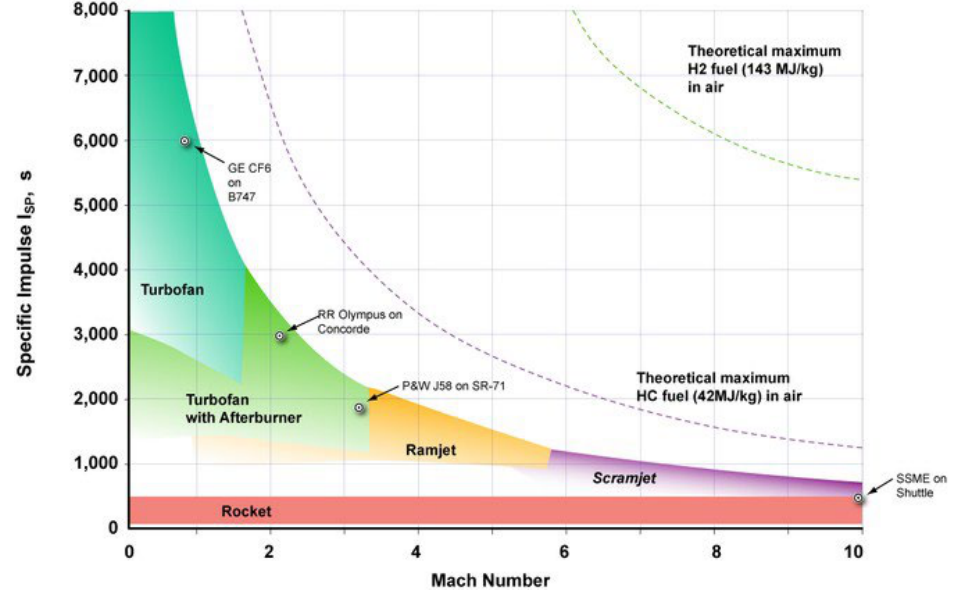
Figure 1. Specific impulse of different engines [1]. Traditionally, space planes and rockets equipped for hypersonic flight utilised a range of liquid fuels, including kerosene derivatives, alcohols, hydrazine, and LH 2 . LH 2 is